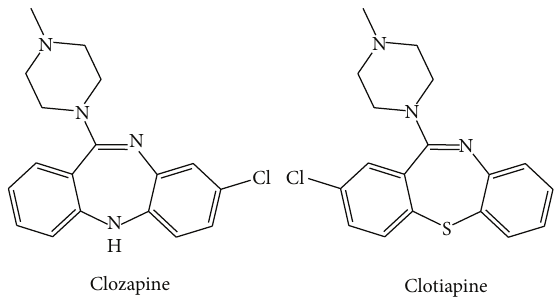
Figure 2: Internal examination: overdistended bladder containing 3.7 L of